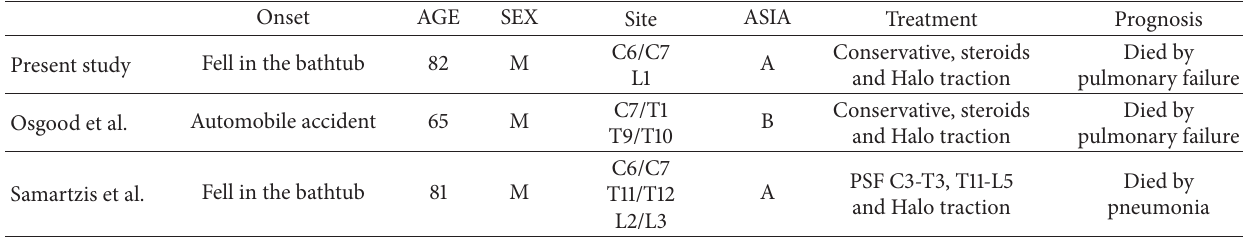
Table 1: Case review of simultaneous spine fractures in patient with